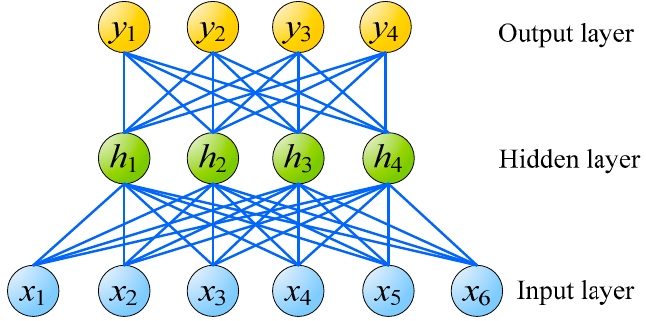
Figure 1. The Multilayer Perceptron (MLP) structure.